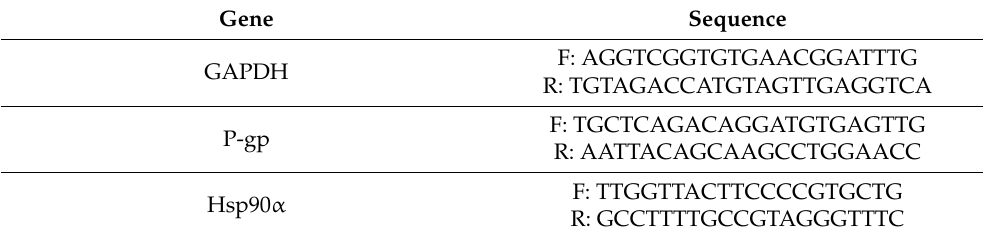
Table 5. Sequence of GAPDH, P-gp, and Hsp90 α primers. Gene Sequence